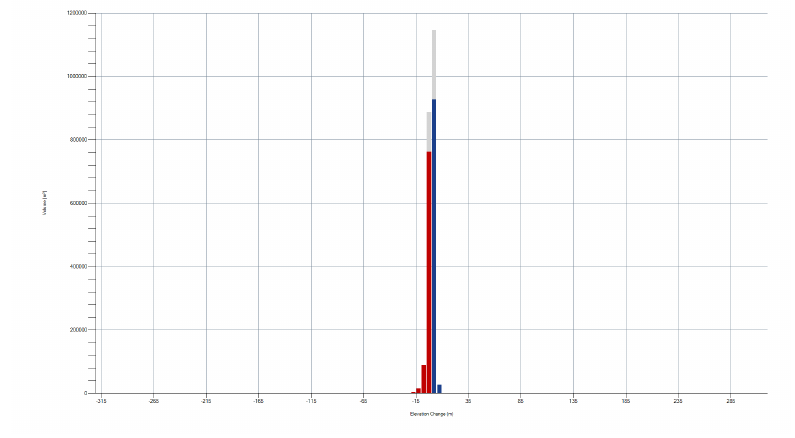
Figure 15. Histogram of elevation